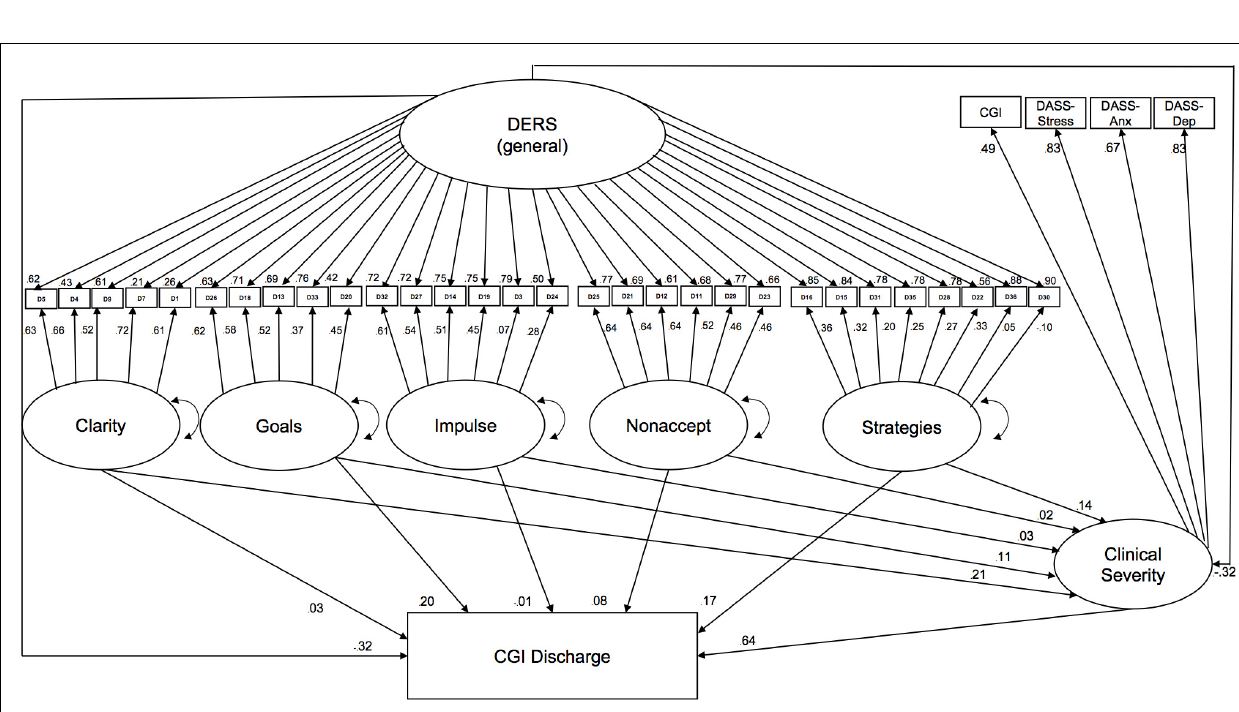
FIGURE 3 | Contribution of the DERS common and specific factors to predicting clinical severity at